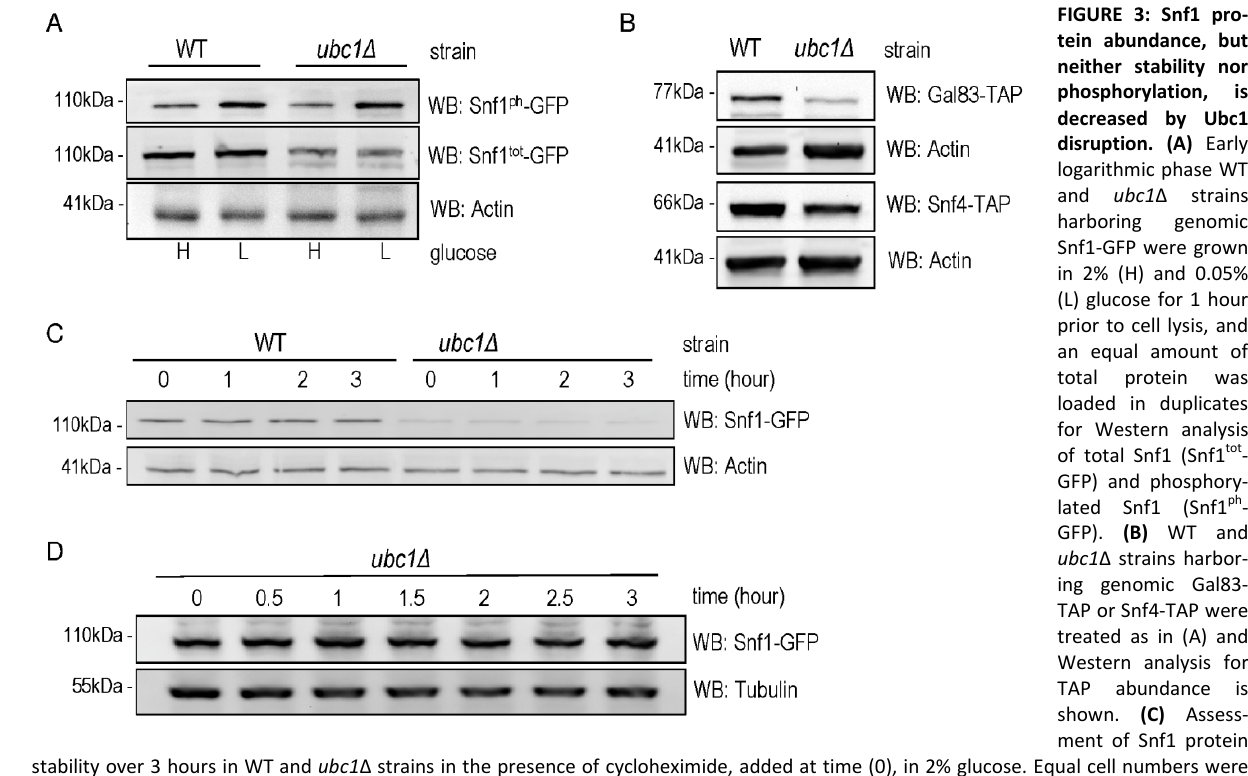
FIGURE 3: Snf1 pro- tein abundance, but neither stability nor phosphorylation, is decreased by Ubc1 disruption. (A) Early logarithmic phase WT and ubc1 Δ strains harboring genomic Snf1-GFP were grown